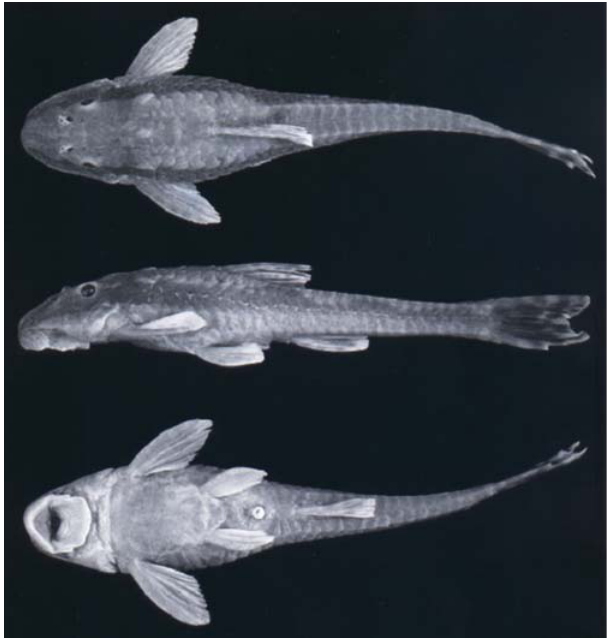
Fig. 2 . Pseudotocinclus tietensis , MZUSP 35235, 50.3 mm SL; small creek near Paranapiacaba, Santo André, São Paulo, Material examined . Brazil, São Paulo: MZUSP 714 (1), 44.0 mm SL, Alto da Serra, near Paranapiacaba, Santo André (Paratype of